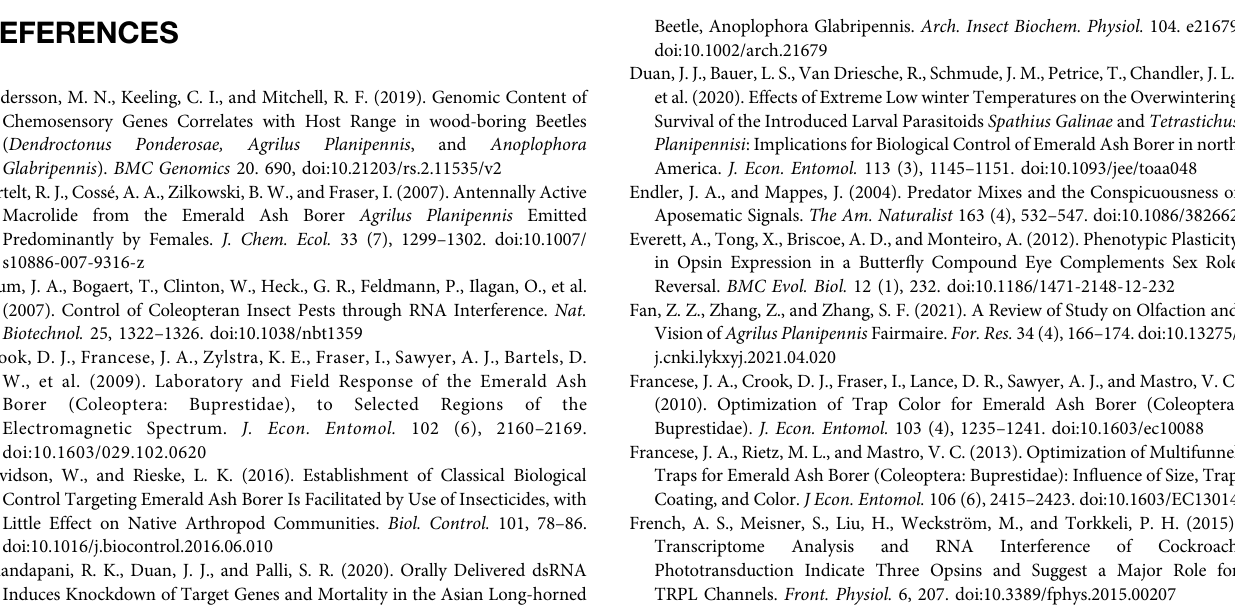
Supplementary Figure S1 | Integrity of dsRNAs of candidate genes and dsEGFP synthesized in vitro by agarose gel analysis. M: DNA 2K marker; 1: dsEGFP; 2: dsOBP10; 3: dsOBP7; 4: dsOBP5; 5: dsLW1; 6: dsUV2; 7: dsUV3. Supplementary Figure S2 | Agarose gel analysis of PCR products of candidate genes and reference gene (TEF-1 α ). M: DNA 2K marker; 1: OBP10 ; 2: OBP7 ; 3: OBP5 ; 4: LW opsin 1 ; 5: UV opsin 2 ; 6: UV opsin 3 ; 7: TEF-1 α . Supplementary Figure S3 | Dissociation curves of candidate genes during qPCR reaction. Supplementary Figure S4 | OriginalgelofdsRNAsofcandidategenesanddsEGFP synthesized in vitro. Supplementary Figure S5 | Original gel of PCR products of candidate genes and reference gene (TEF-1 α